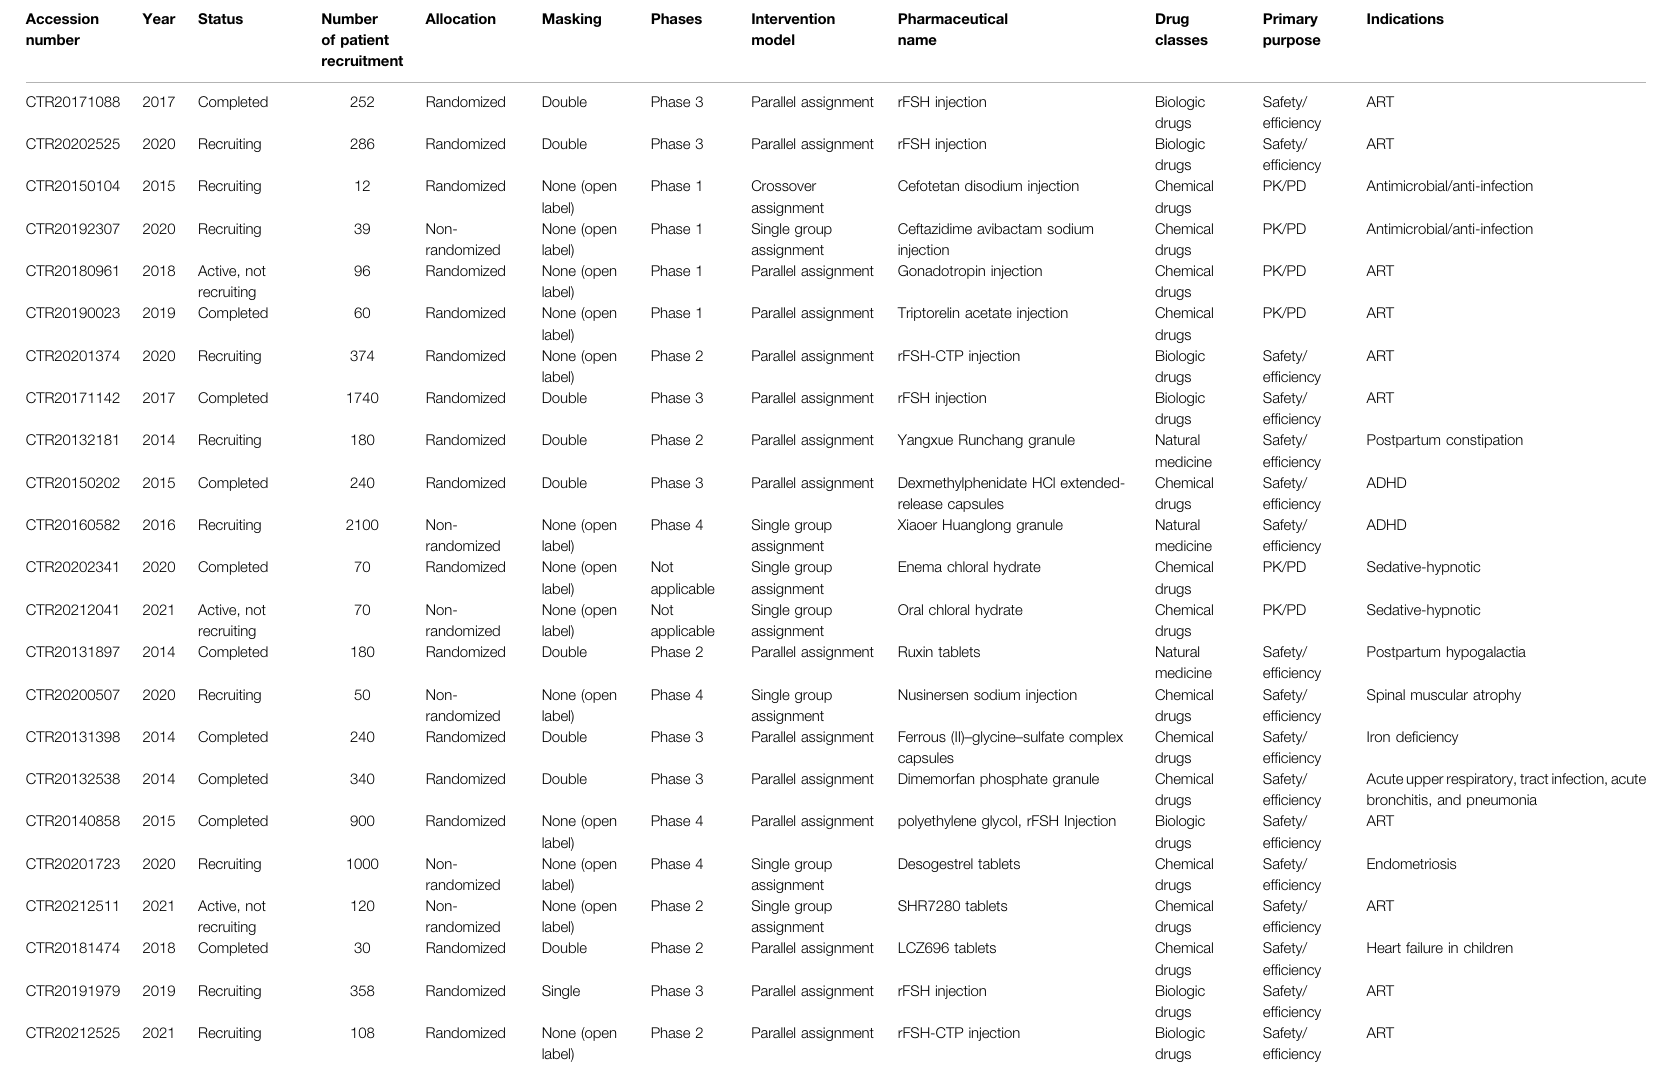
TABLE 4 | Trials on pregnant women according to the inclusion criteria after exclusion of trials of cancer and/or of postmenopausal